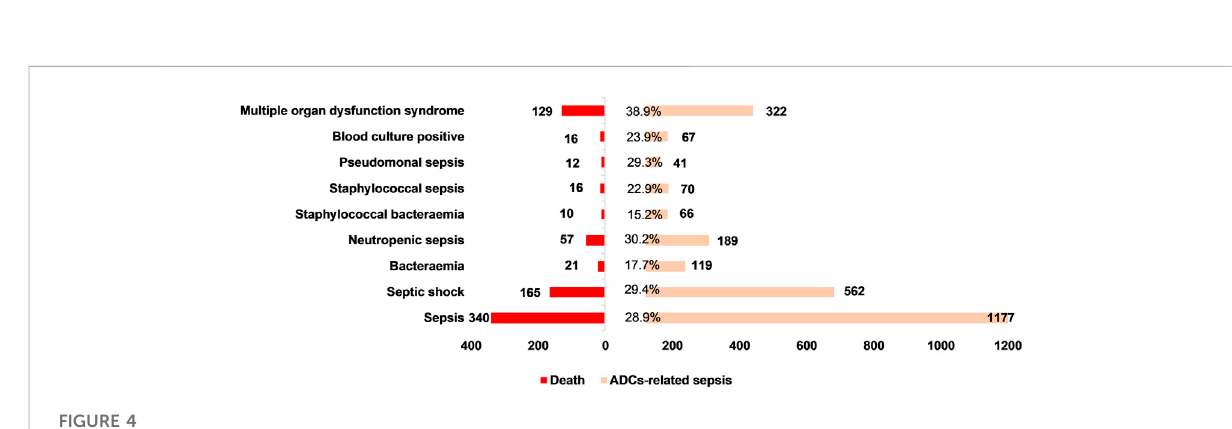
FIGURE 4 Death cases and their proportion in ADC-related